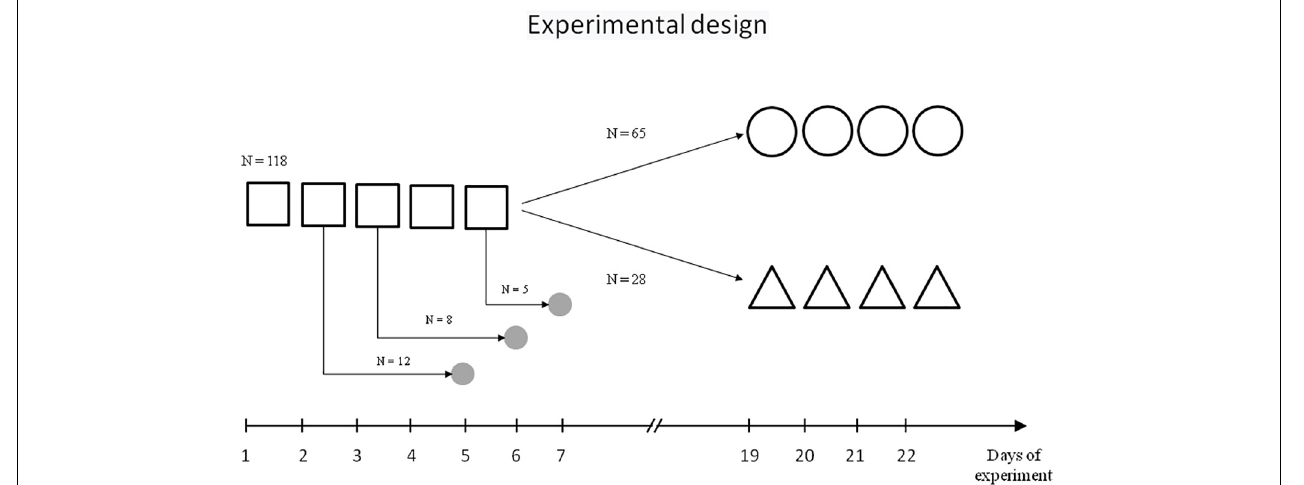
FIGURE 1 | Scheme of